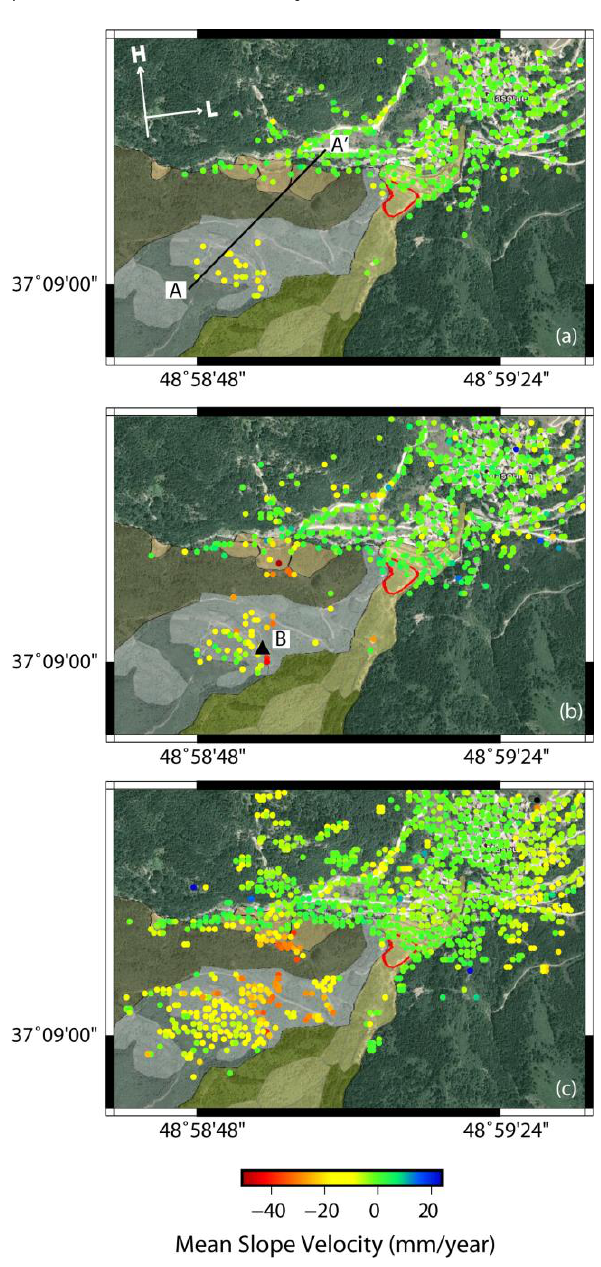
Figure 4. Displacement map in slope direction for (a) PSI, (b) SBAS and (c) SqueeSAR methods. The solid line AA’ in Figure 4(a) shows the profile used for comparsion between 3 methods in Figure 6. The vectors H and L represent the satellite heading and look direction, respectively. Point B in Figure 4(b) is selected for time series analysis that is plotted in Figure 5.